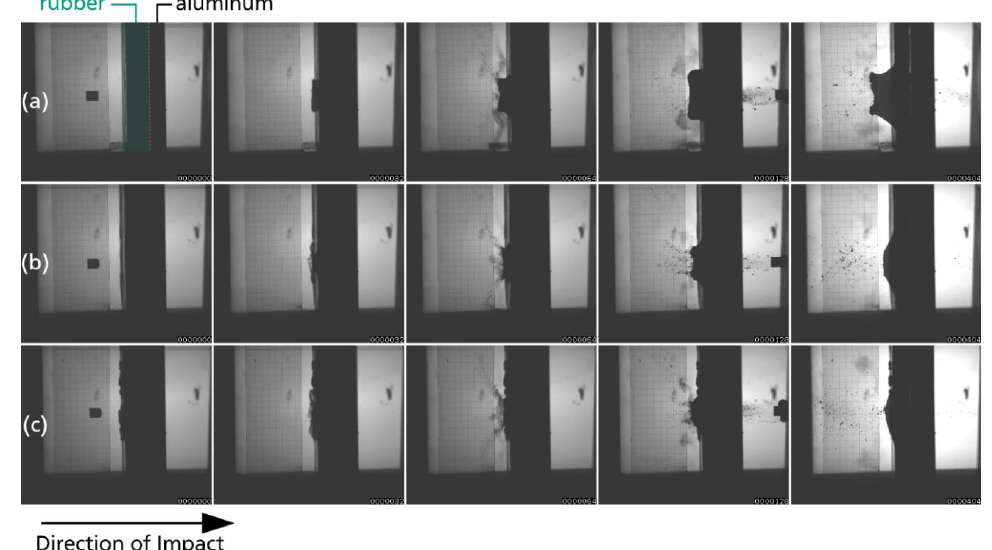
Figure 8. High-speed photographs of the impact behavior of ( a ) BR/NR (9:1), ( b ) IIR, ( c ) SBR. Photographs were taken after 0, 32, 64, 128 and 404 μs. A schematic colorized overlay in the first photograph ( a ) highlights the rubber front-layer and aluminum back-layer.